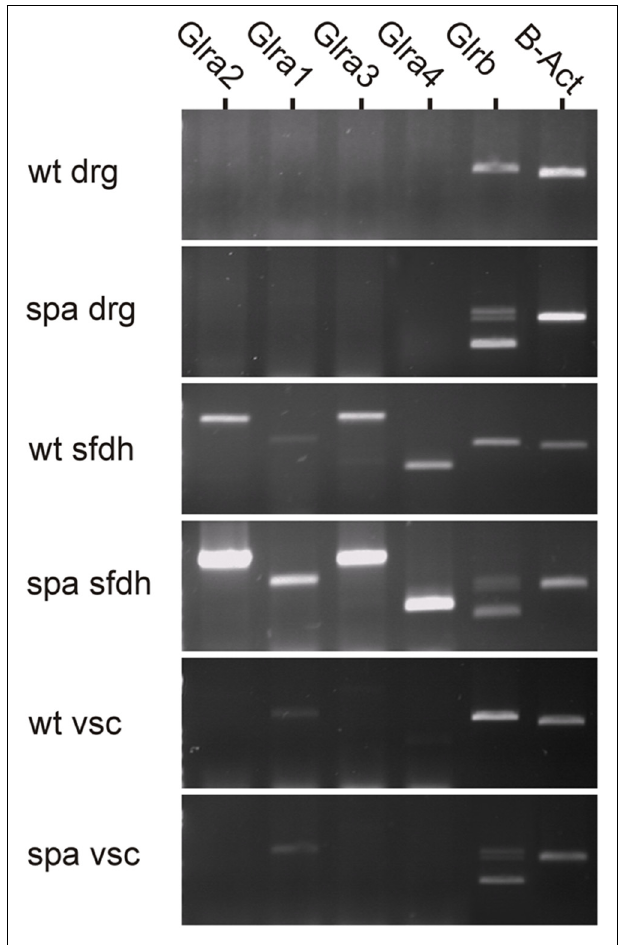
FIGURE 1 | Region-specific expression of GlyR mRNA at the spinal level. GlyR mRNA expression was investigated in dorsal root ganglia (drg), superficial dorsal horn (sfdh) and ventral horn of the spinal cord (vsc). For GlyR β , multiple bands in tissues derived from Glrb spa/spa animals correspond to truncated transcripts generated by exon skipping (413 bp, transcript lacks exons 4 and 5; 643 bp, transcript lacks exon 5); the upper band represents the full-length transcript (726 bps; Mülhardt et al., 1994). No GlyR α subunit RNA could be detected in DRGs, whereas GlyR β was expressed. Transcripts encoding GlyR α 1–4 and GlyR β were found in the superficial dorsal horn (sfdh; sizes: α 1: 831 bp; α 2: 1,152 bp; α 3: 1,158 bp; α 4: 509 bp; β - full length: 726 bp). The predominant subunit in the ventral spinal cord (vsc) was GlyR α 1 (low signal). In Glrb spa/spa mice, the regional distribution of glycine receptor mRNAs remained